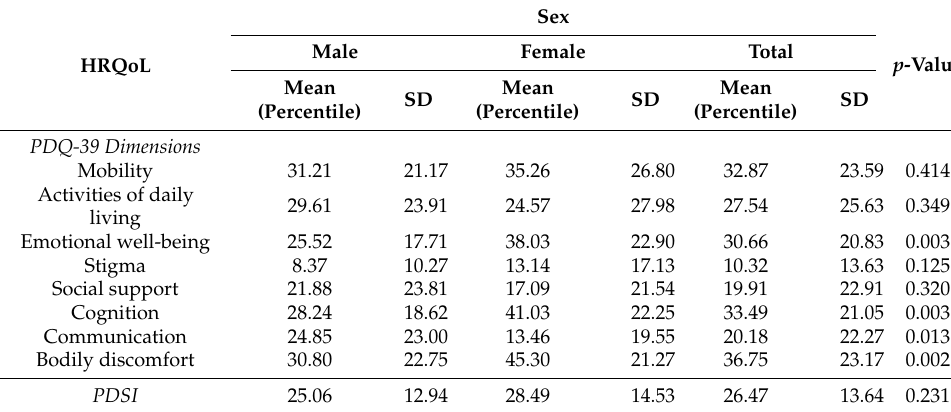
Table 3. Dimensions of the PDQ-39 and PDSI in the study